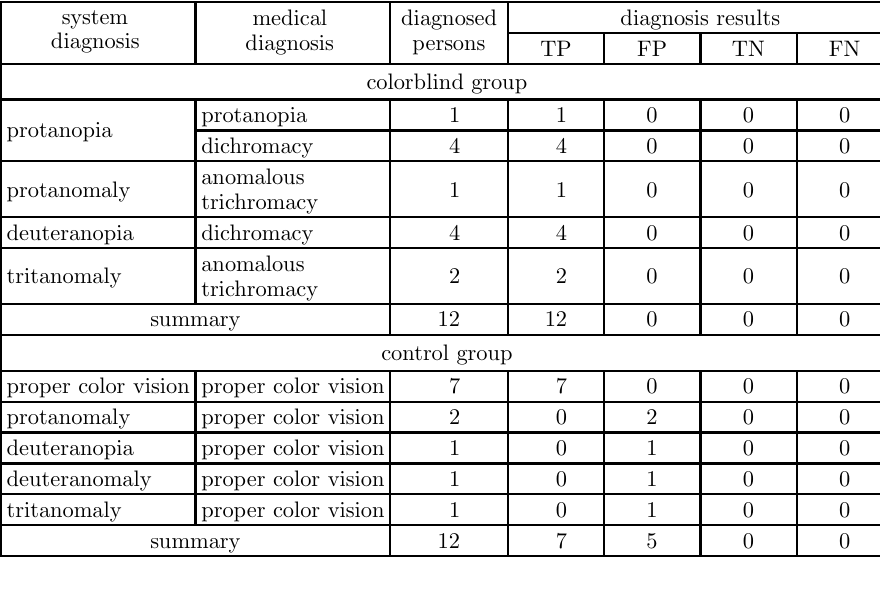
Table 3. Results for experiment